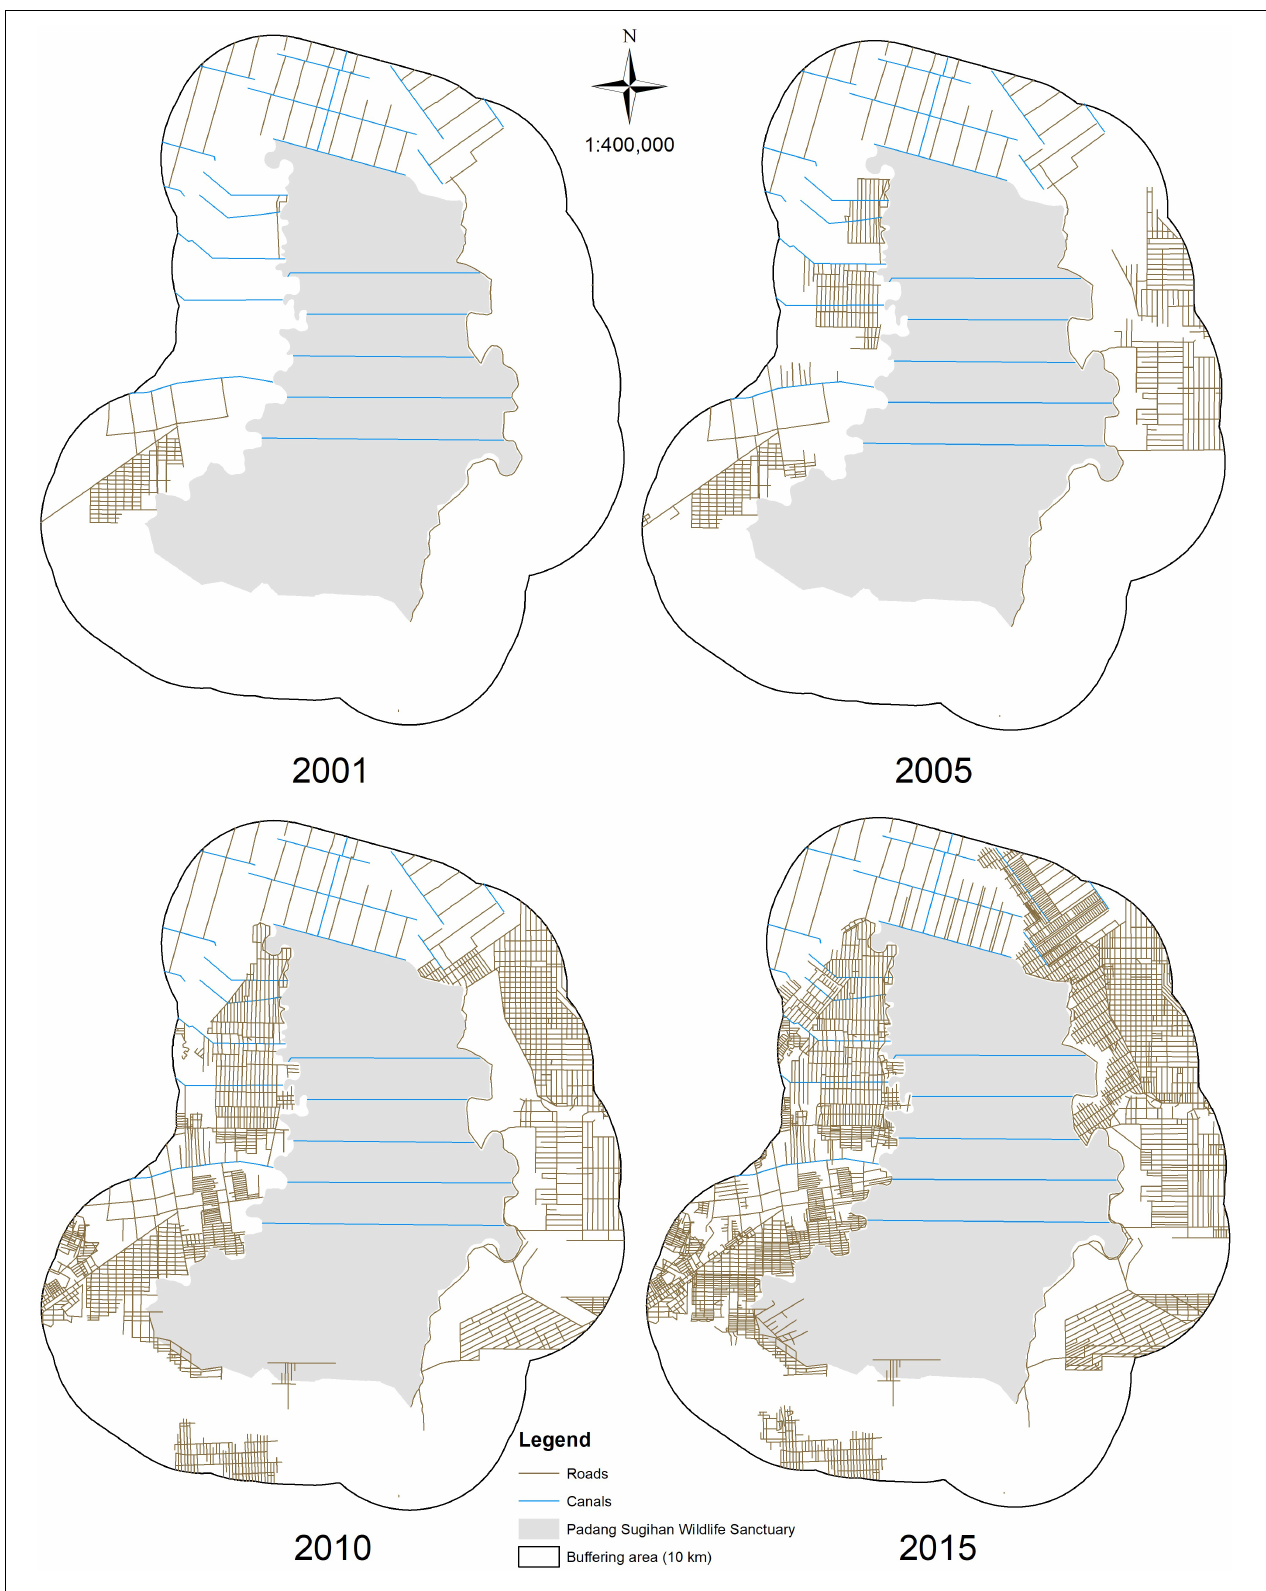
FIGURE 2 | Road and canal development during 2001–2020 surrounding and within PSWR, Sumatra, Indonesia.